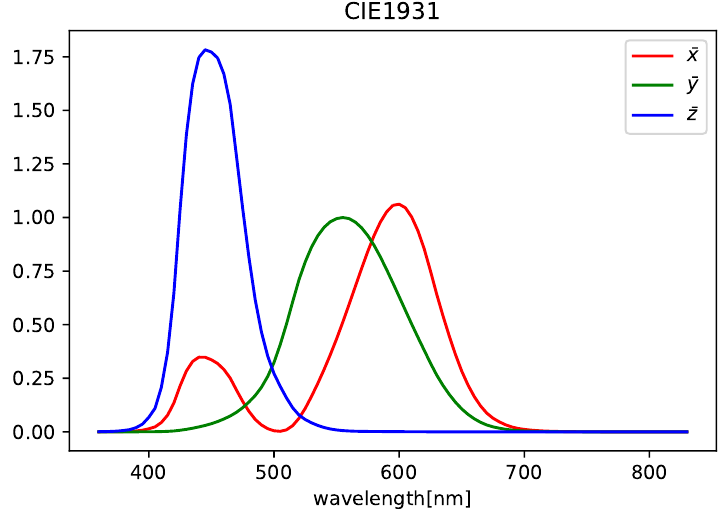
Figure 1. CIE1931 color matching